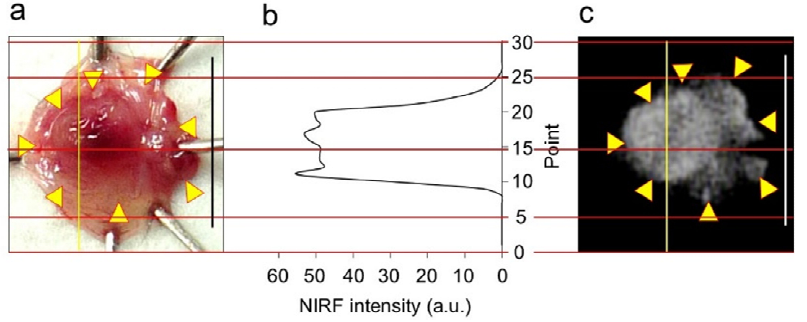
Figure 6. Near-infrared fluorescence (NIRF) intensity in cancerous bladder tissues. ( a ) Bladder inner layer under white light. ( b ) NIRF intensity on yellow line in ( a , c ). ( c ) NIRF image of bladder inner layer shown in photo ( a ). Scale bar in photos ( a , c ) represents 10 mm. Yellow arrows in photo ( a ) show points of boundary between NIRF and non-NIRF based on the photo ( c ). Red lines are scale lines common to ( a – c ).